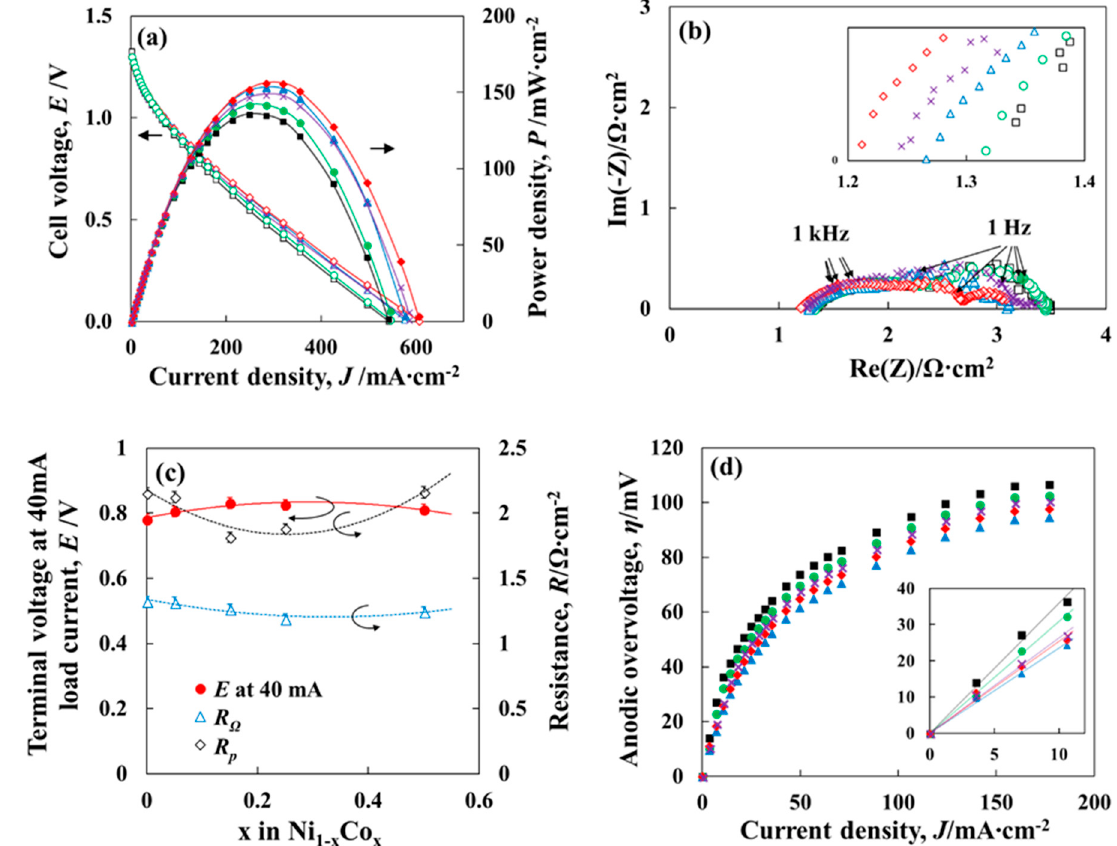
Figure 3. ( a ) Current–voltage curves (open symbols) and power densities (closed symbols), ( b ) AC impedance spectra measured at open circuit voltage (OCV), ( c ) the cell voltage at a constant current, the ohmic resistance and the polarization resistance as a function of x, and ( d ) the anodic overvoltages of the Ni 1–X Co X cell at 750 °C for the H 2 supply: x = 0 ( ■ , □ ); x = 0.05 ( ● , ○ ); x = 0.15 ( ▲ , △ ); x = 0.25 ( ◇ , ◆ ); x = 0.50 (X). The symbols in Figure 3c are different from Figure 3a,b and d.